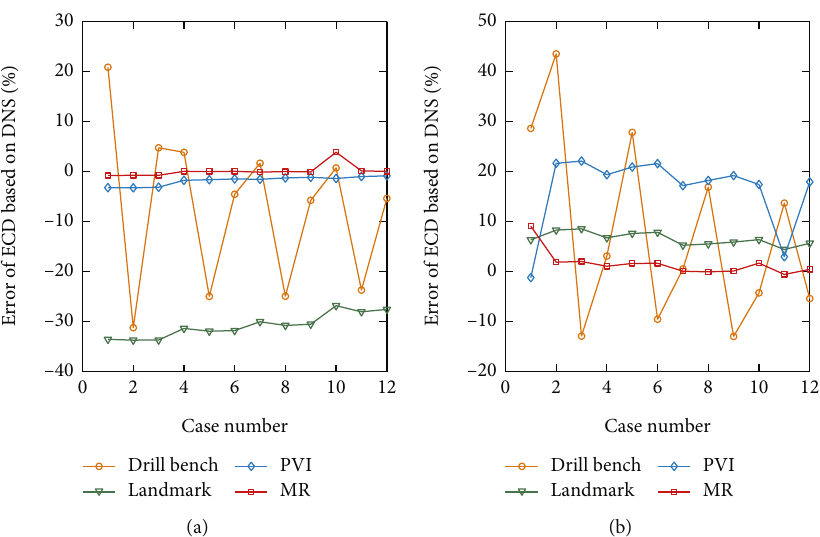
Figure 5: Error analyses of the ECD results between the DNS method and other four methods; (a, b) are the analysis results for the Bingham model and Power-Law model.